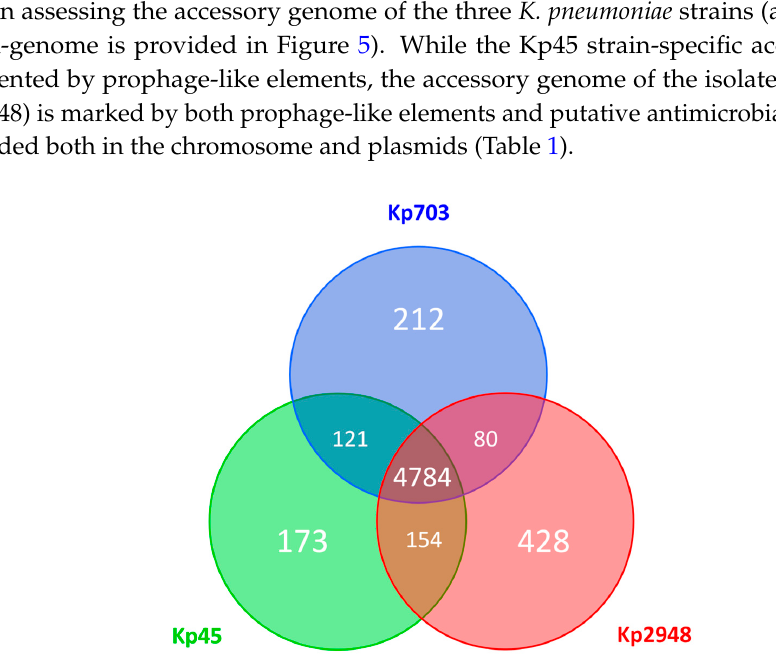
Figure 5. Pan-genome overview. The Venn diagram shows the number of shared and unique predicted coding sequences (CDSs) among the three K. pneumoniae isolates (Kp703, Kp45 and Kp2948) deduced from a Basic Local Alignment Search Tool (BLASTP) analysis performed using RAST, where protein sequences with more than 75% of sequence identity were considered as homologues. Circles are not drawn to scale.